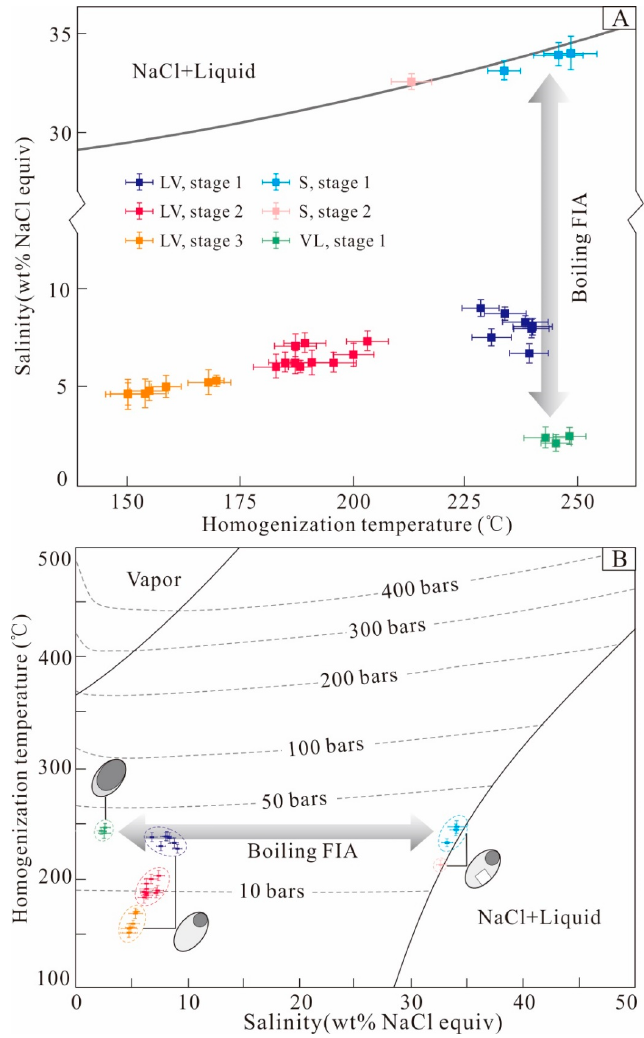
Figure 7. ( A ) Homogenization temperature vs. salinity in the NaCl − H 2 O system for FIAs from stages 1 − 3 in the Kuergasheng Pb − Zn deposit; ( B ) Pressure estimates for FIs of the Kuergasheng Pb–Zn deposit. Isobars were calculated using the equations of Driesner and Heinrich [31].